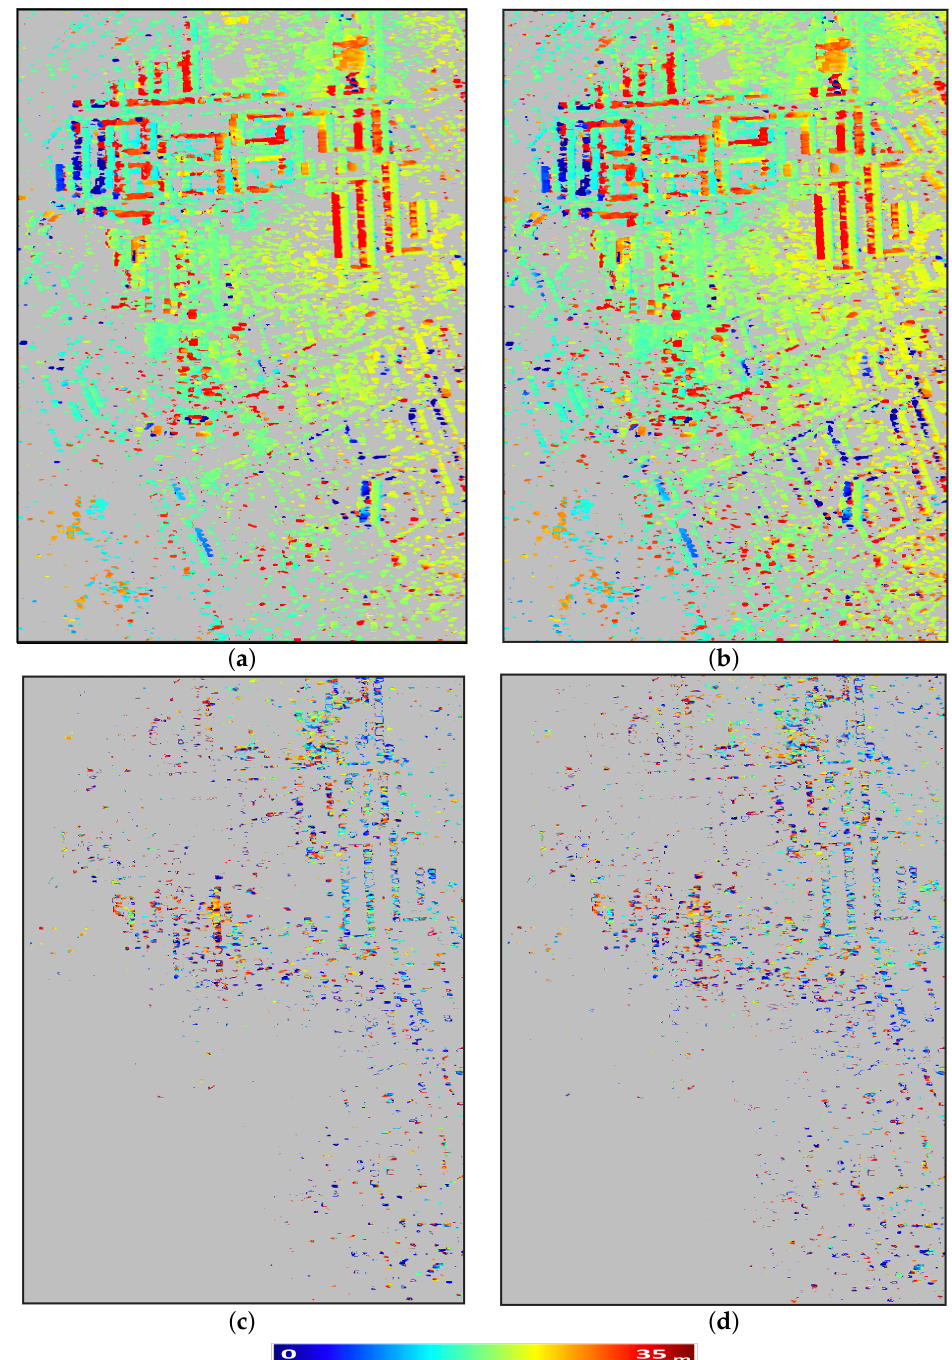
Figure 3. Performance assessment of the employed methods using the ESAR real data set. ( a , b ) de- tected single scatterers using the existing scattering-based support GLRT (10) and the proposed detection (16). ( c , d ) detected double scatterers using the scattering-based support GLRT (11) and the proposed detection (17). The colors of the scatterers show their elevations when the standard JET colormap is set to the range of [0.1 cm–35